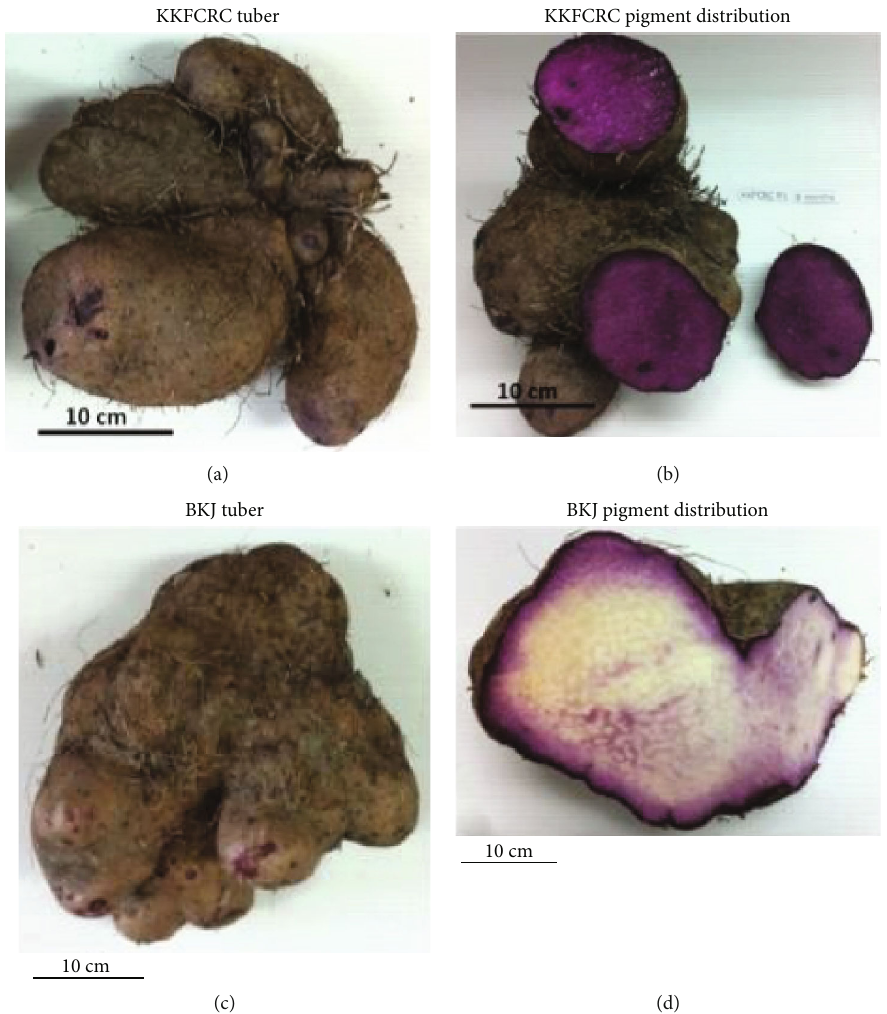
Figure 1: Appearance of tuber and purple pigment distribution in Dioscorea alata fl esh from 8-month-old